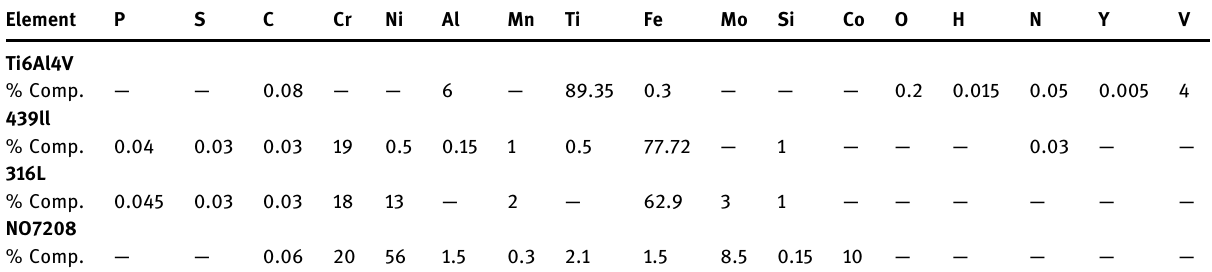
Table 1: Nominal ( wt% ) constituent of 439ll, 316L, NO7208, and Ti6Al4V alloy Element